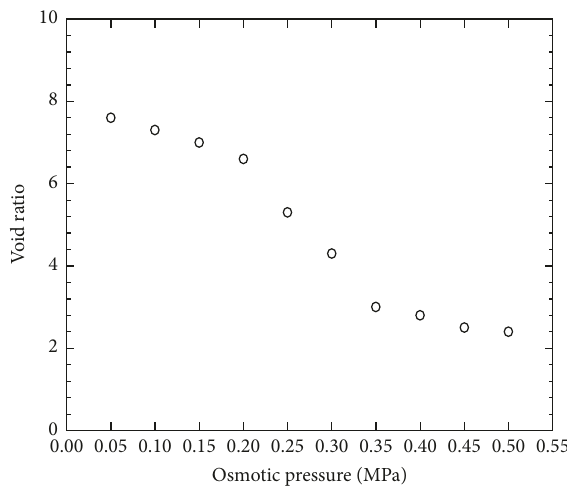
Figure 5: GCLs compression